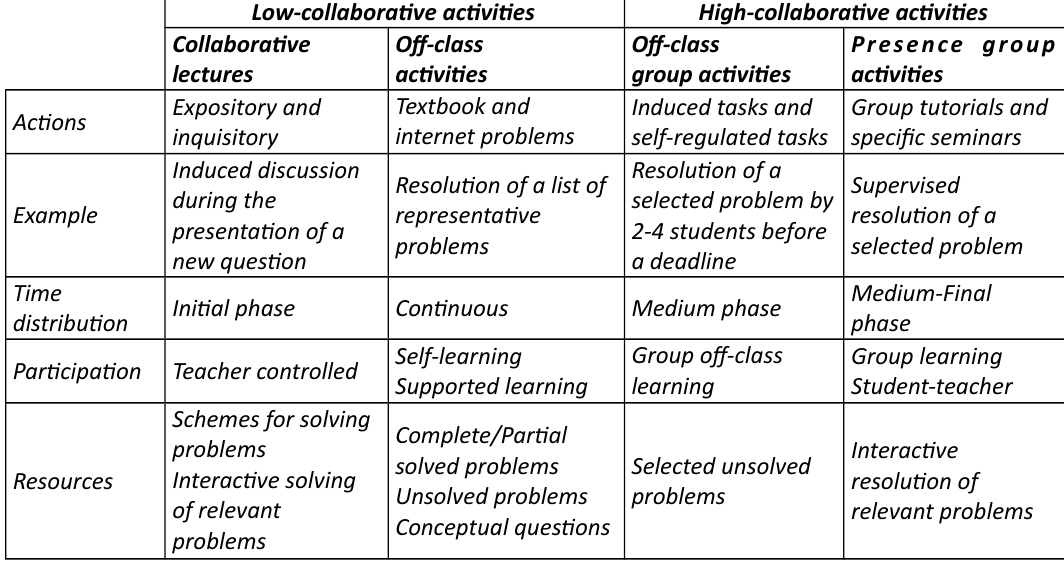
Table 1. Studied collaboratve actvites for learning queston